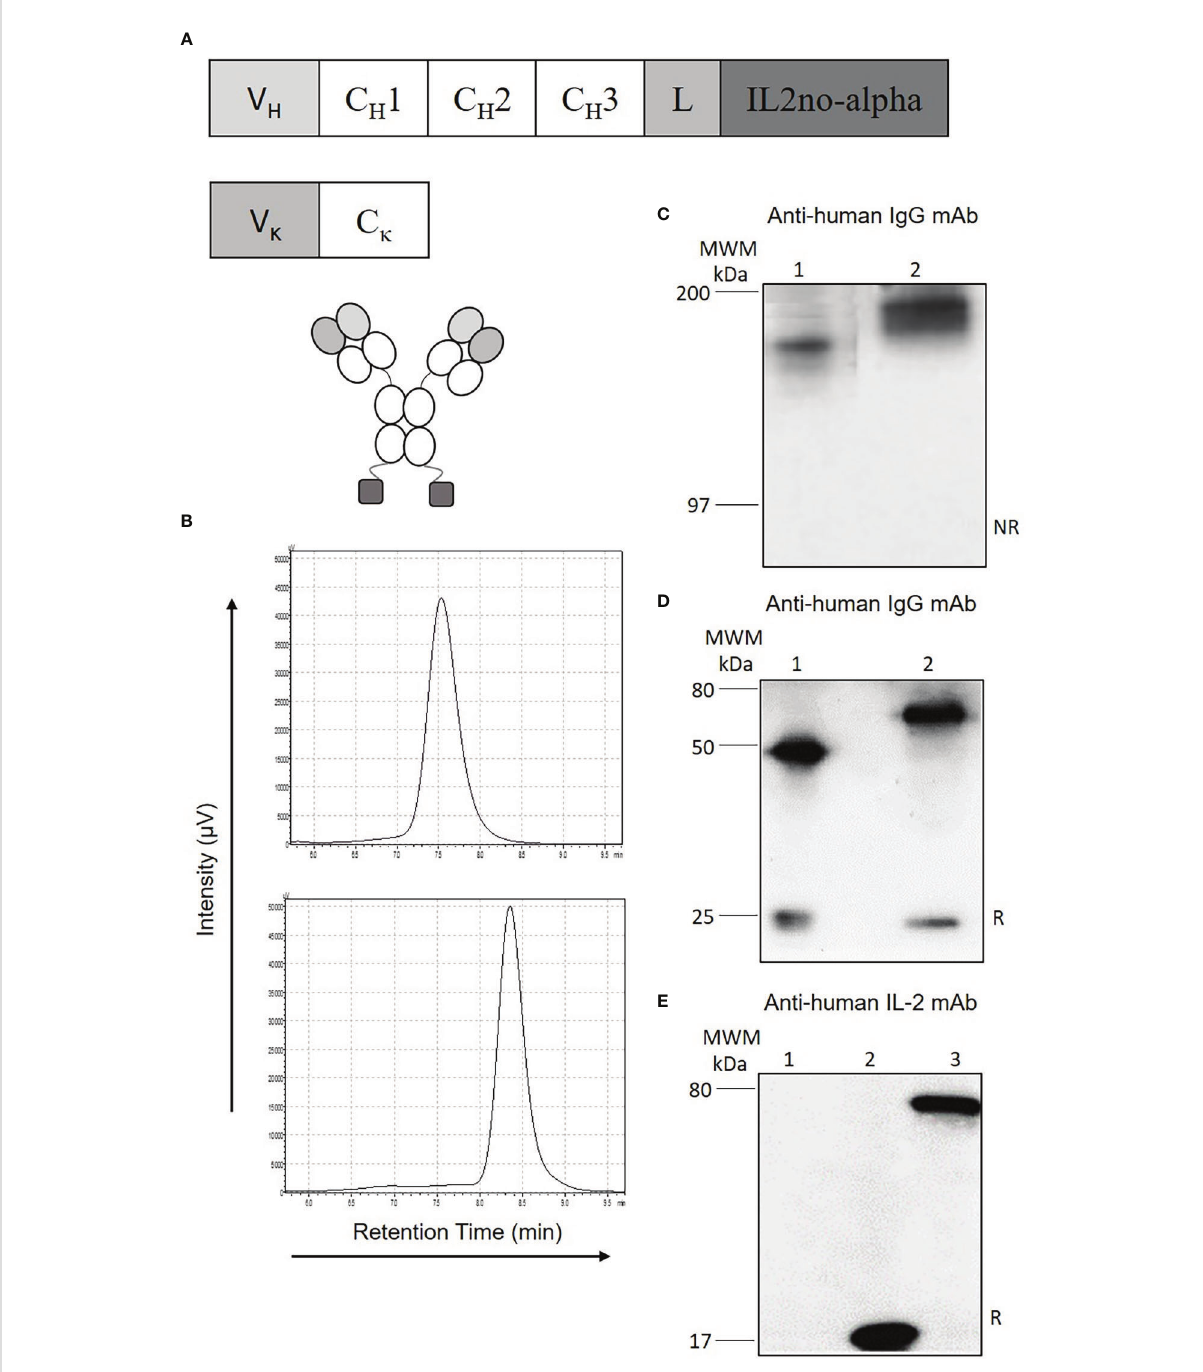
FIGURE 1 Design and characterization of anti-huCD20(h g 1)-IL2no-alpha ICK. (A) Schematic representation of anti-huCD20(h g 1)-IL2no-alpha (CH1, CH2, CH3, constant region of human g 1 heavy chains; L, amino-acid linker (Gly4Ser) 3 GT; V, variable domain of RTX. (B) Gel fi ltration analysis of RTX (upper panel) or puri fi ed anti-huCD20(h g 1)-IL2no-alpha (lower panel). (C – E) , Western blot analysis using anti-human-IgG antiserum in (C) non- reducing conditions and (D) reducing conditions (Lane 1: RTX, lane 2: anti-huCD20(h g 1)-IL2no-alpha) or (E) using anti-IL-2 rabbit polyclonal antibodies (Lane 1: RTX, lane 2: mutein IL2no-alpha, lane 3: anti-huCD20(h g 1)-IL2no-alpha). MWM, Molecular Weight Marker. NR, non-reducing conditions; R, reducing